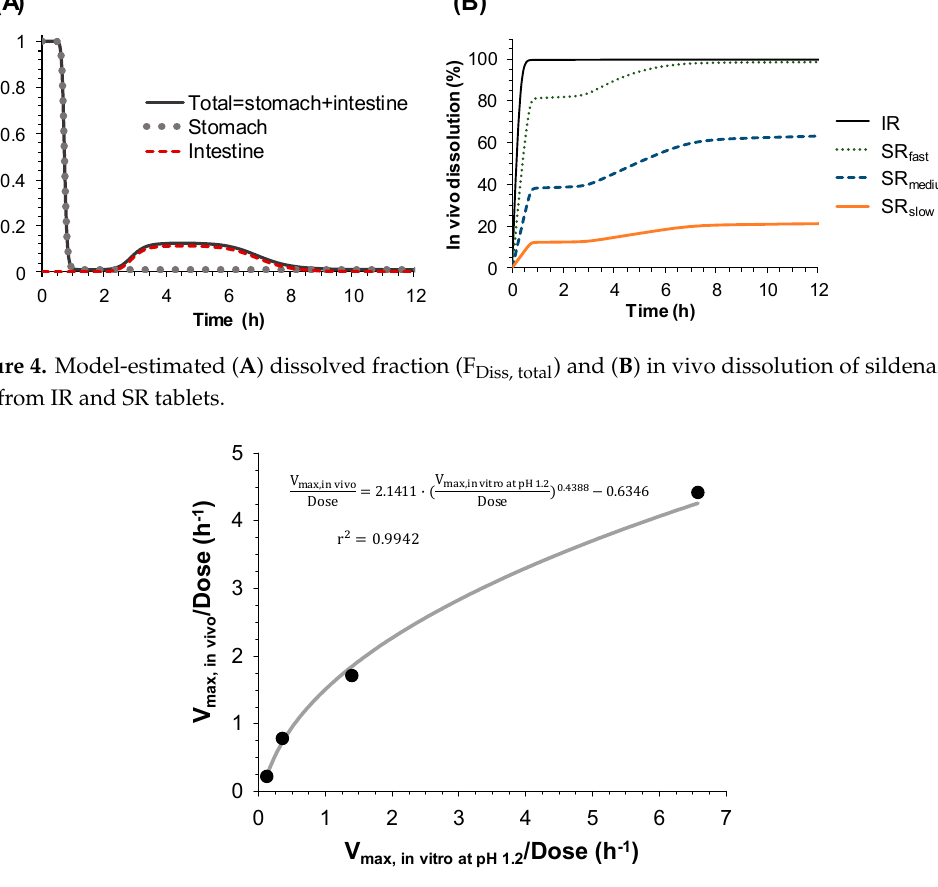
Figure 5. Correlation between the V max estimates for in vitro and in vivo dissolution by a power regression.